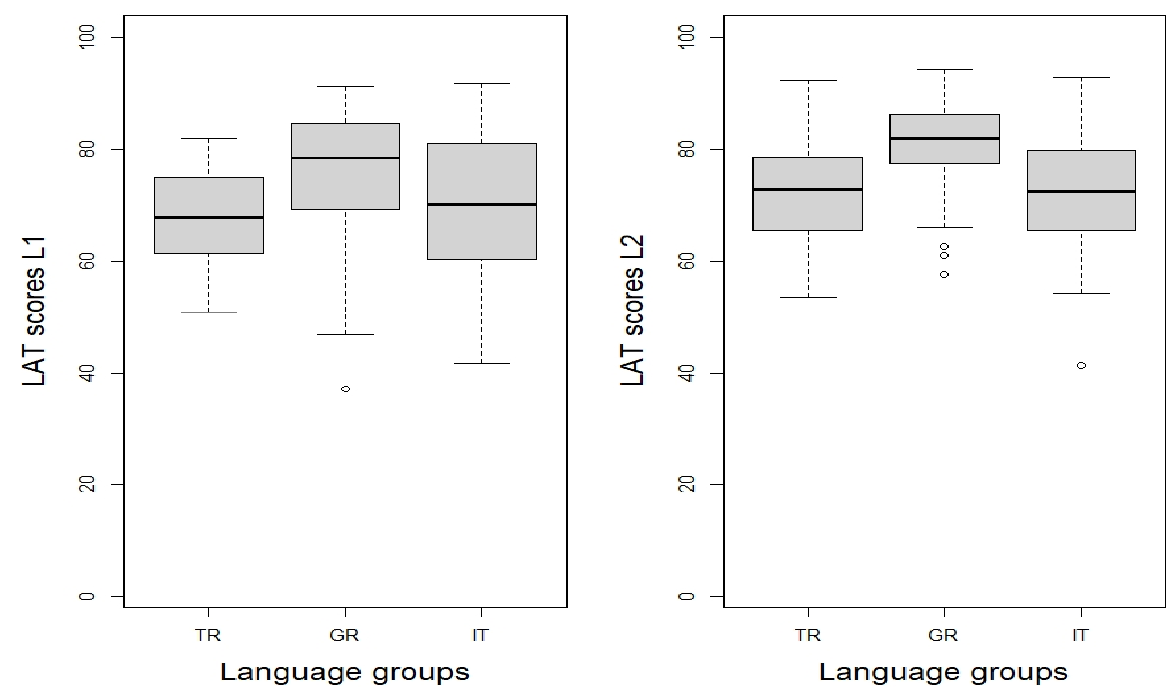
Figure 5. LAT scores in L1 and L2 across the language groups.